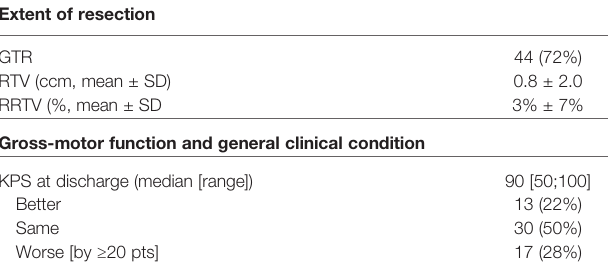
TABLE 2 | Patient outcome.